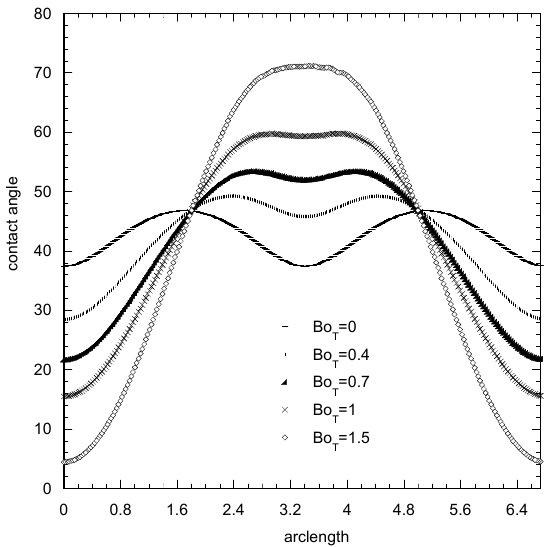
Figure 3. Contact angle (degrees) distribution along a pinned elliptical contact line (aspect ratio = 1.25) for increasing Bond number. Dimensionless volume V = 0.6.